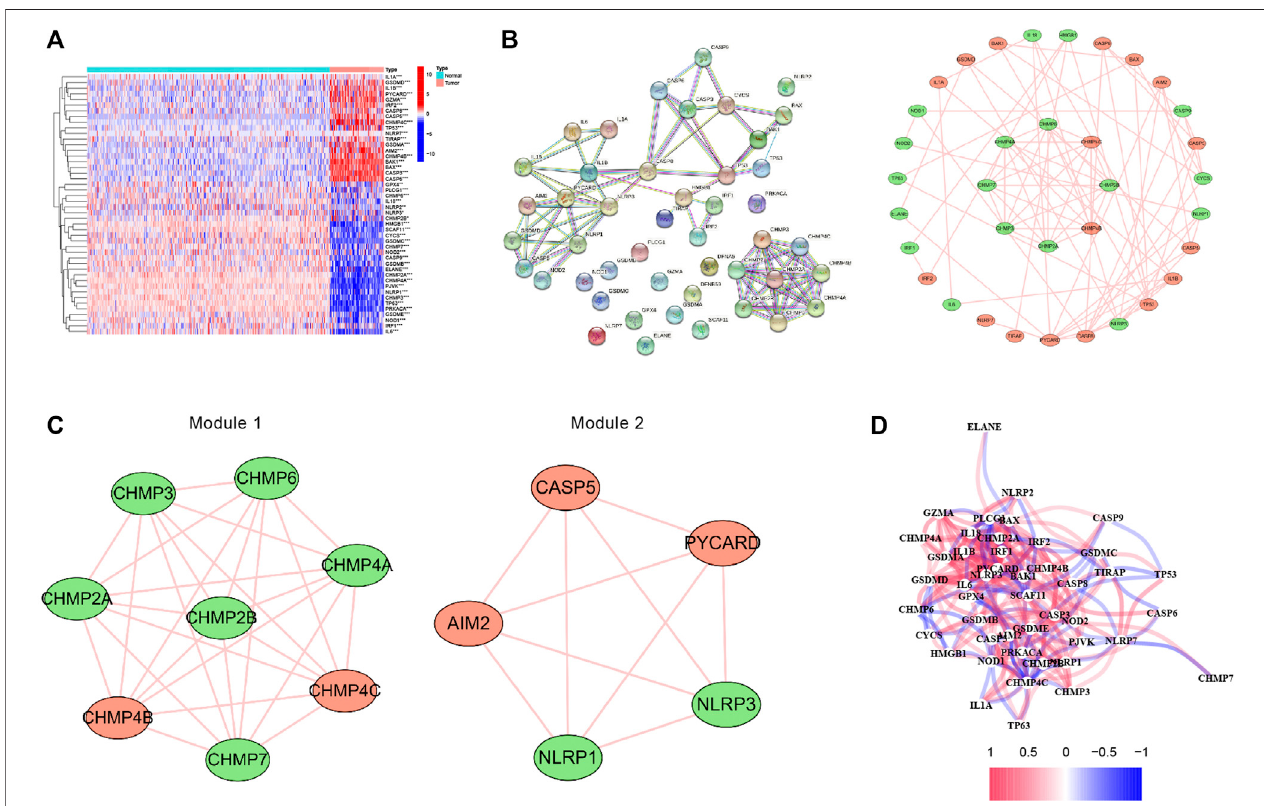
FIGURE 2 | Expression and interconnectedness of the pyroptosis-related genes in osteosarcoma. (A) The heatmap showed the differential expressed PRGs between human osteosarcoma samples and normal muscle tissues (red: high expression level, blue: low expression level). (B) PPI network of differentially expressed PRGs (TherednodesindicateupregulatedPRGsand thegreennodesindicatedownregulated PRGs) (C) CriticalmodulesfromthePPInetwork. (D) The correlation network of the differential expressed PRGs (red lines indicate positive correlation and blue lines indicate negative correlation). PRGs, pyroptosis- related